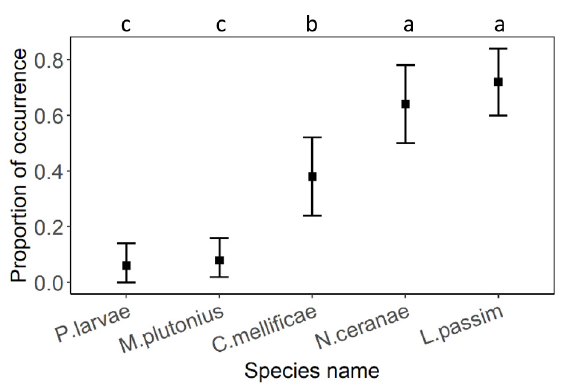
Table 2. The results of the analysis of deviance (likelihood-ratio test) testing the partial effect of habitat type and pathogen species identity on the species richness and occurrence of pathogens in the honey bee colonies. Likelihood-ratio analysis testing of whether the Akaike information criterion bacterial brood diseases were observed. In contrast, A. apis and N. apis were not detected at (AIC) of the full model significantly increased after a particular explanatory variable was excluded from the model.